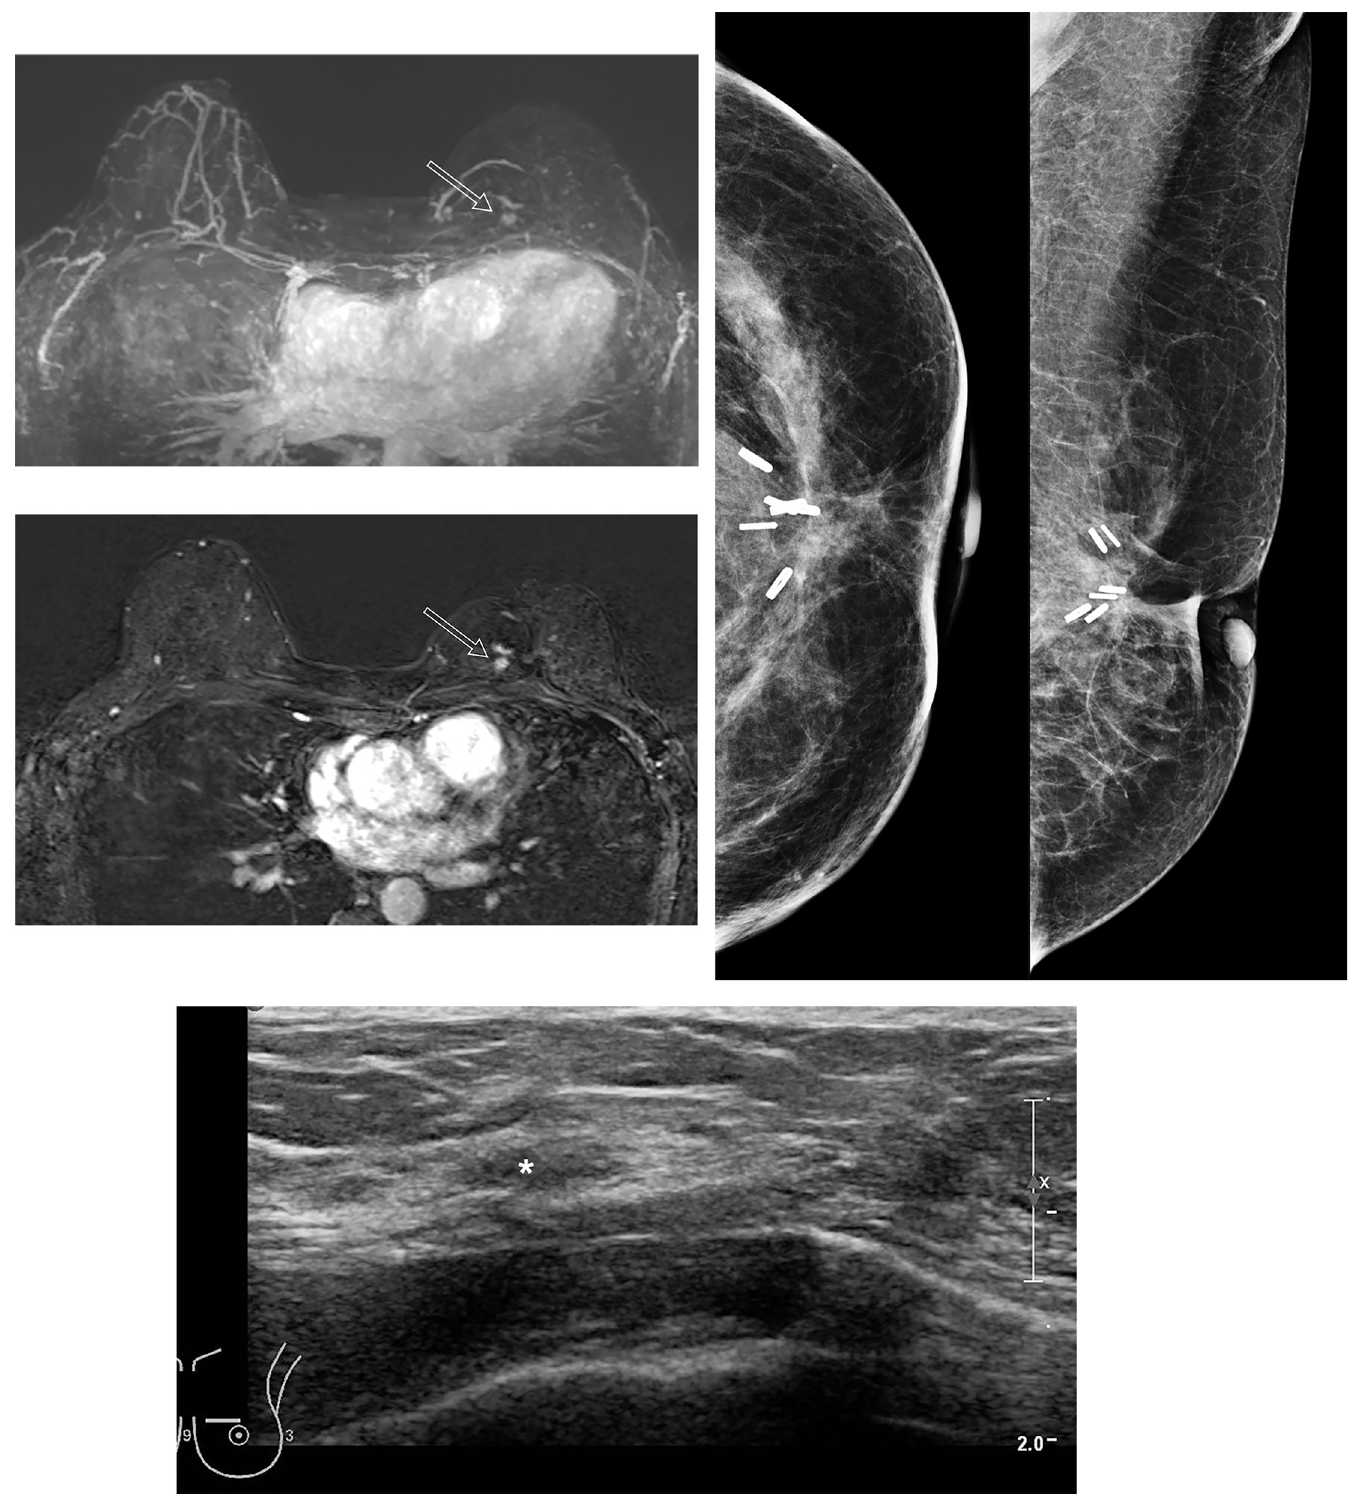
Fig 5. A 62-year-old female patient with an early recurrent breast cancer detected 12 months after BCT. (a) MIP image of postoperative MRI after 12 months from BCT for left breast cancer. There is a prominent nodular enhancement at upper inner quadrant of left breast (open arrow). (b) On subtracted early dynamic phase of contrast enhanced T1WI, a brightly enhancing nodule is noted adjacent to previous BCT site (open arrow). (c) There is no abnormal finding on mammography of the